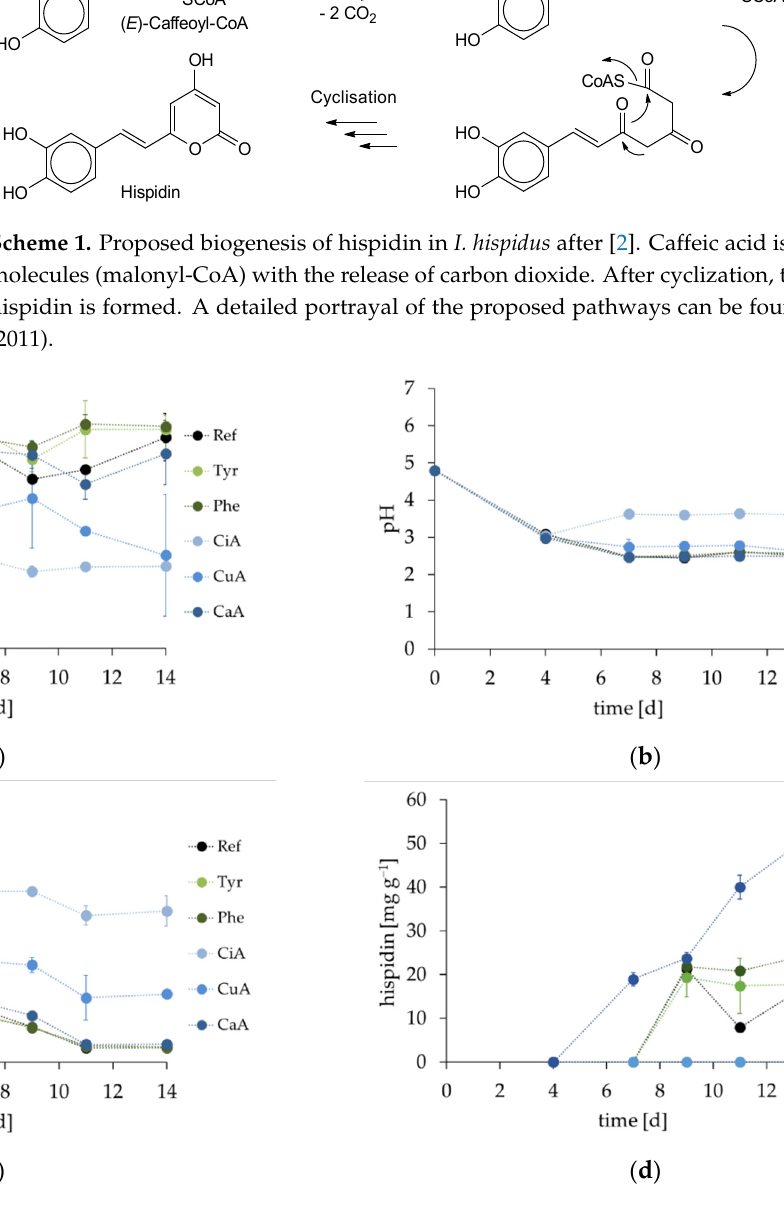
Figure 3. Cultivation of I. hispidus with precursors (2 mM supplemented on days 4, 7, 9, and 11). The control (Ref.) is depicted in black, L -tyrosine (Tyr) in light green, L -phenylalanine (Phe) in dark green, cinnamic acid (CiA) in light blue, p -coumaric acid (CuA) in blue, and caffeic acid (CaA) in